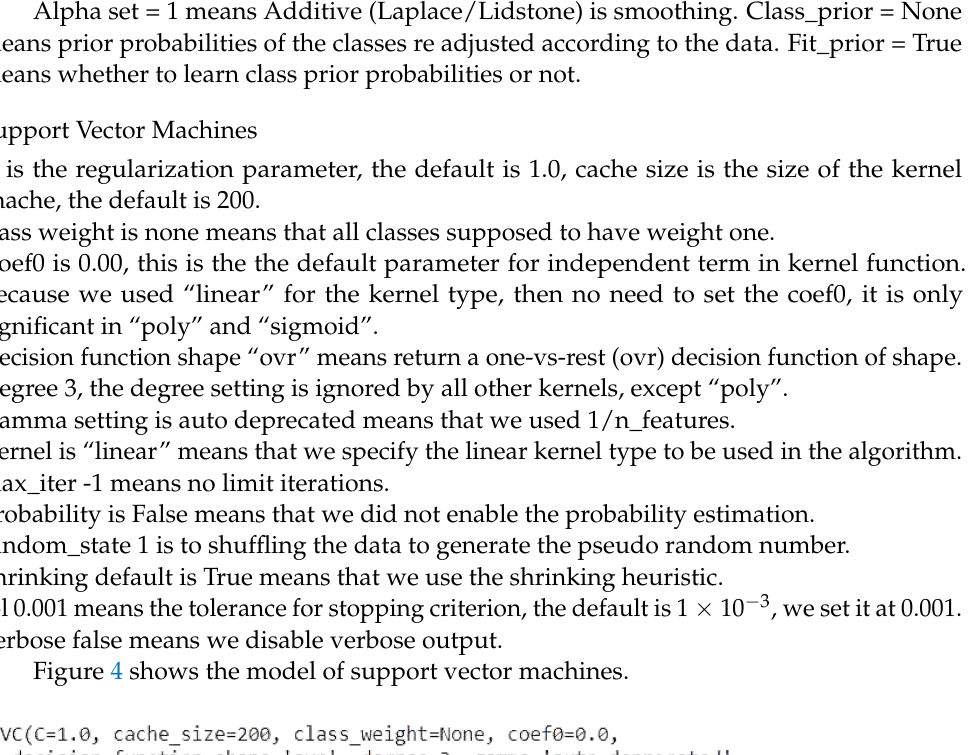
Figure 3. Binomial Logistic Regression Model. Naive Bayes Classifier